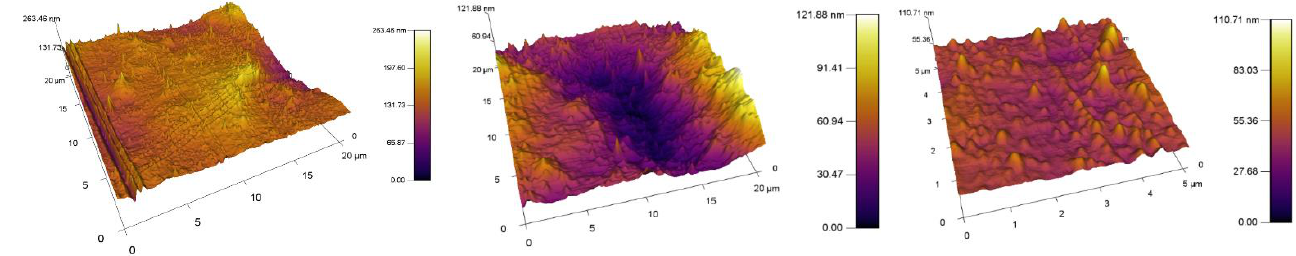
Figure 7 . Different topography of unmodified surfaces of PVC . Figure 7. Different topography of unmodified surfaces of PVC. The obtained results of the increased surface area and roughness for polymer films PVC modified by DCSBD plasma discharge realized for both sides (DUAL) in exposure types I, II, III and IV are shown in Table 2 and Figure 8. Table 2 . Comparison of surface area increase and change of roughness on PVC polymer film sur- faces after different types of modification using DCSBD plasma discharge.